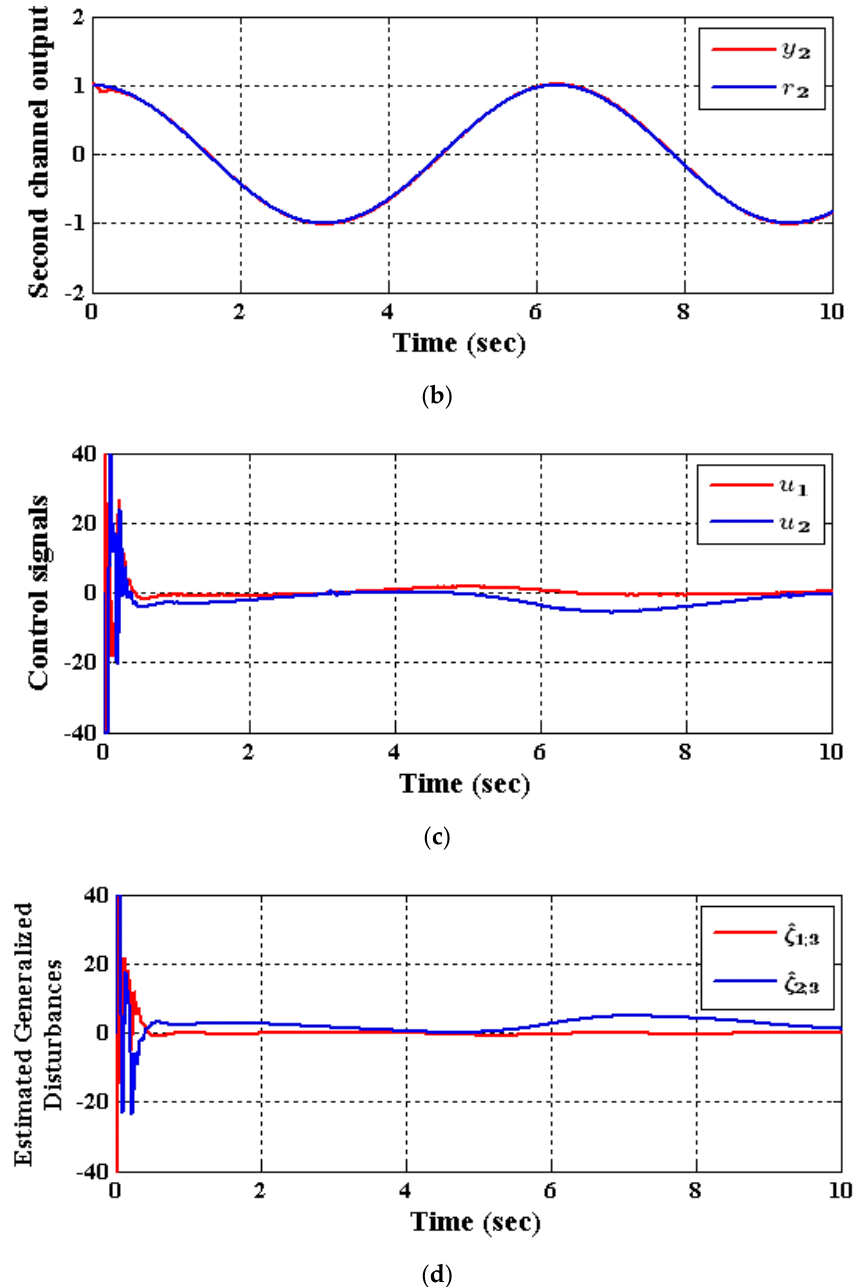
Figure 11. The output response of (42) using IADRC, ( a ) output curve y 1 , ( b ) output curve y 2 , ( c ) control signals u 1 and u 2 , and ( d ) estimated generalized disturbances ˆ ξ 1,3 and ˆ ξ 2,3